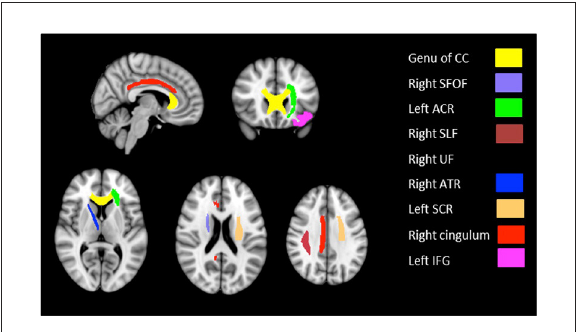
FIGURE2 Masks of nine ROIs selected from the results of whole-brain group comparison overlaid on MNI152 template brain.